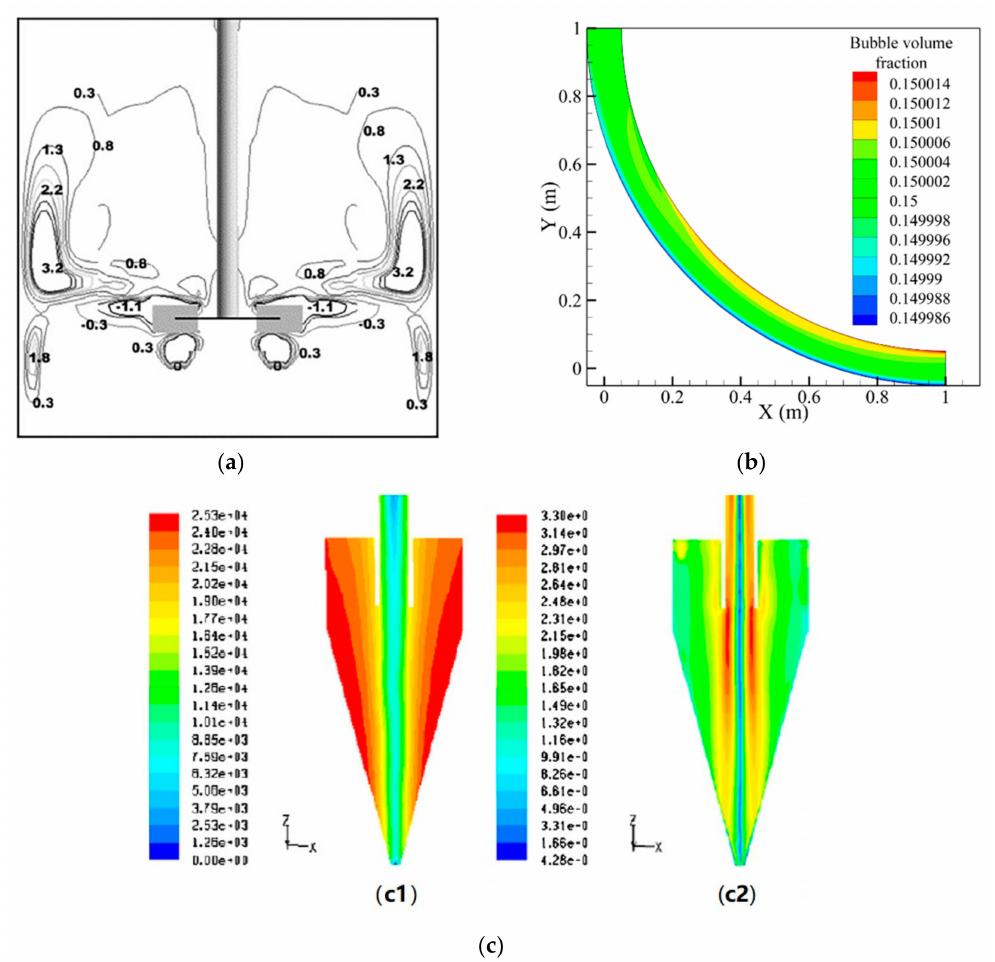
Figure 4. Examples of computational fluid dynamics (CFD) multiphase modeling in mineral processing. ( a ) CFD-predicted net attachment rates after flotation time in the stirred cell [31]; ( b ) Bubble volume fraction (unit in vol %) distribution in a pipe for a backfill material [32]; ( c ) Predicted contours of ( c1 ) pressure and ( c2 ) tangential velocities in Renner’s cyclone